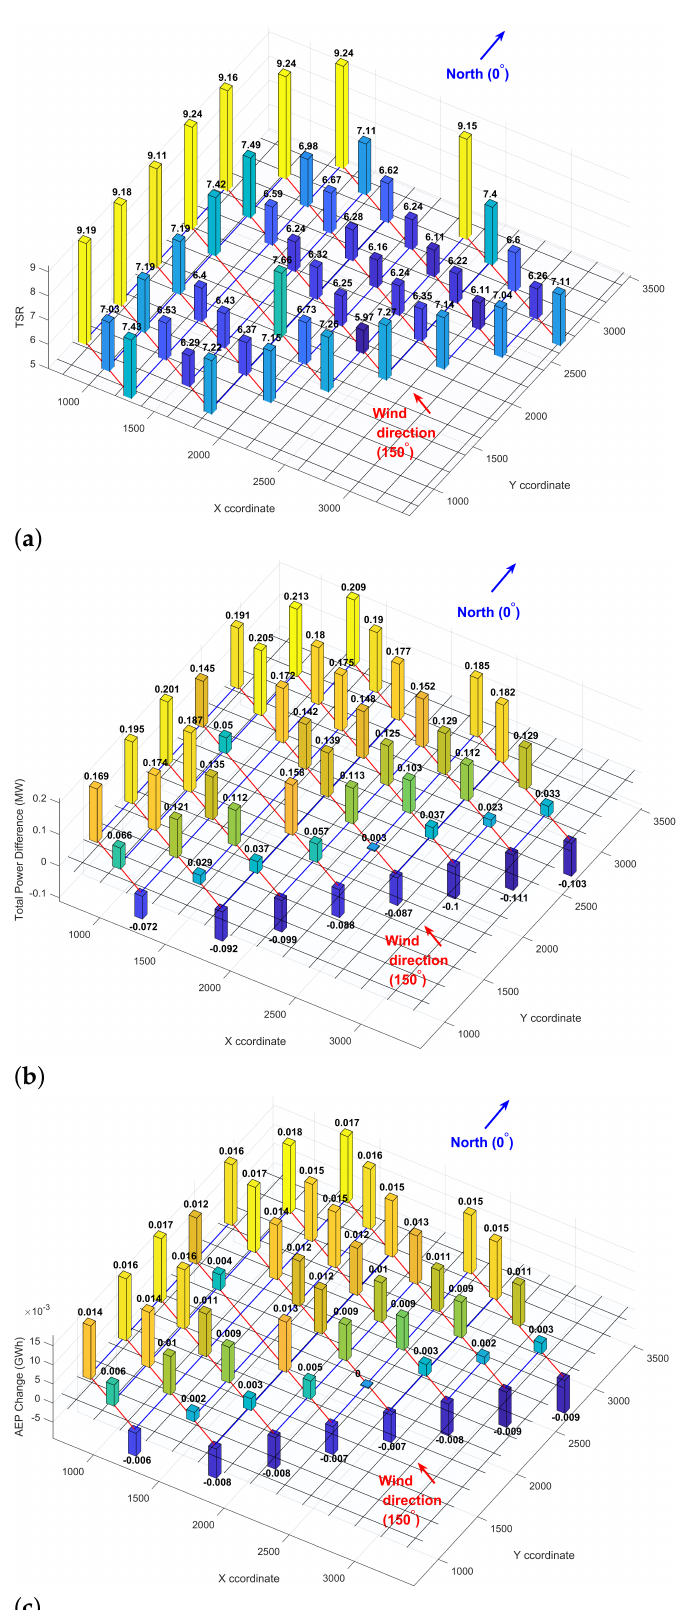
Figure 7. Optimizing TSR in 150 ◦ : ( a ) Optimal TSR values, ( b ) Changes in power production, ( c ) Changes in